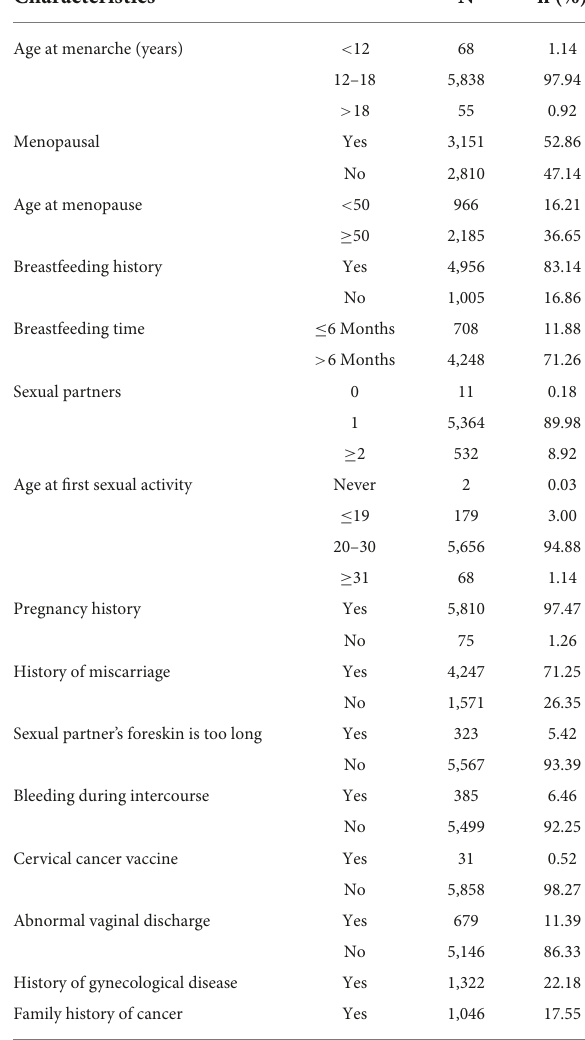
TABLE 2 Personal and family history of the cervical cancer screening